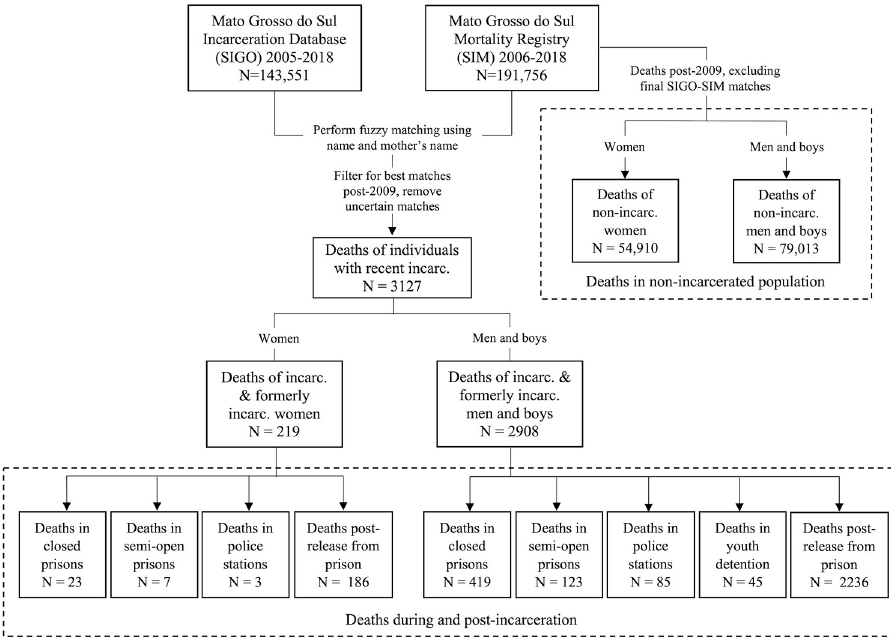
Fig 1. Linkage of incarceration database and mortality registry to identify deaths during and following incarceration in Mato Grosso do Sul state. Deaths of men and boys ages 14 to 95 and women ages 18 to 95 were included. See S2 Fig and S1 Text for filtering and inclusion/exclusion details. incarc, incarcerated/incarceration; SIGO, Sistema Integrado de Gest ã o Operacional (incarceration database); SIM, Sistema de Informac¸ õ es Sobre Mortalidade (mortality